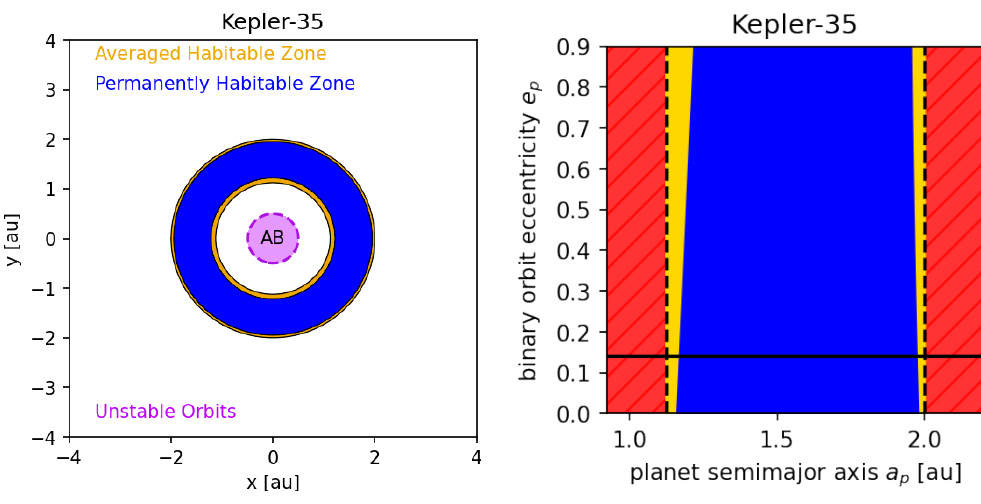
Figure 9. Same as Figure 8, only for a system similar to Kepler-35. This system contains only one Earth-like circumbinary